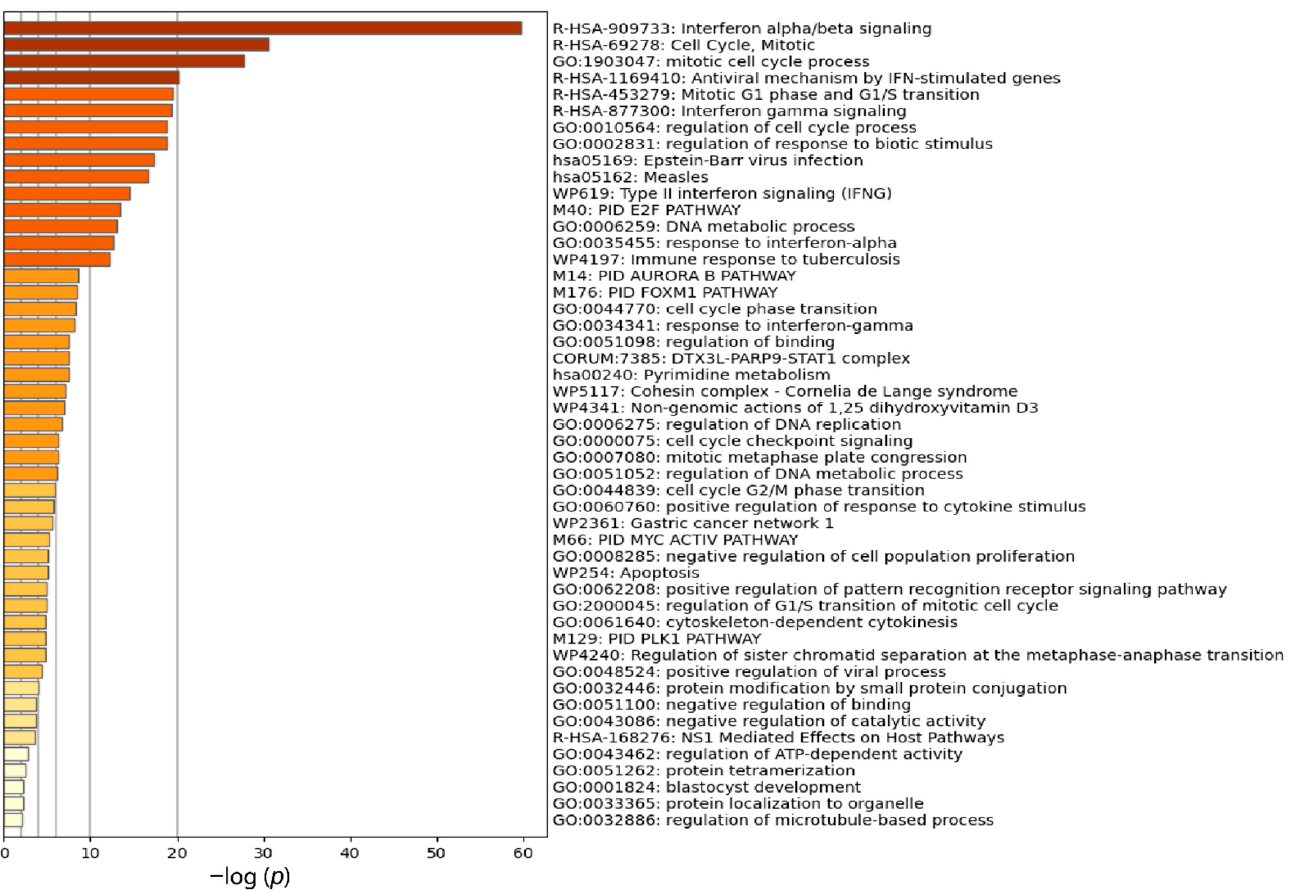
Figure 4. The bar graph represents the enrichment terms analyzed from the IPIN at a significant level ( p -value < 0.01). Each enrichment term is colored based on the significance level.